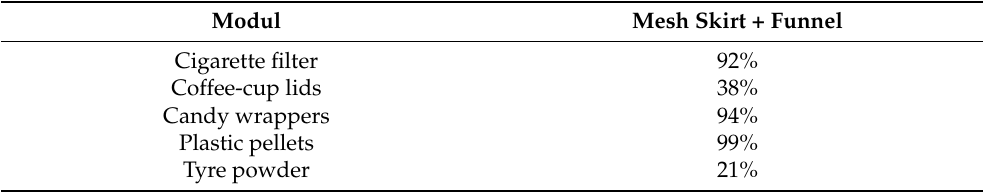
Table 10. Results for defined test